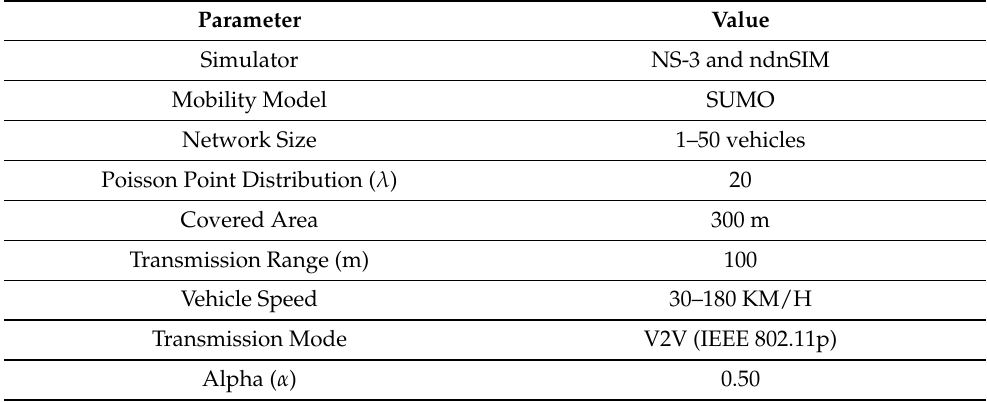
Table 2. Simulation parameters and values.